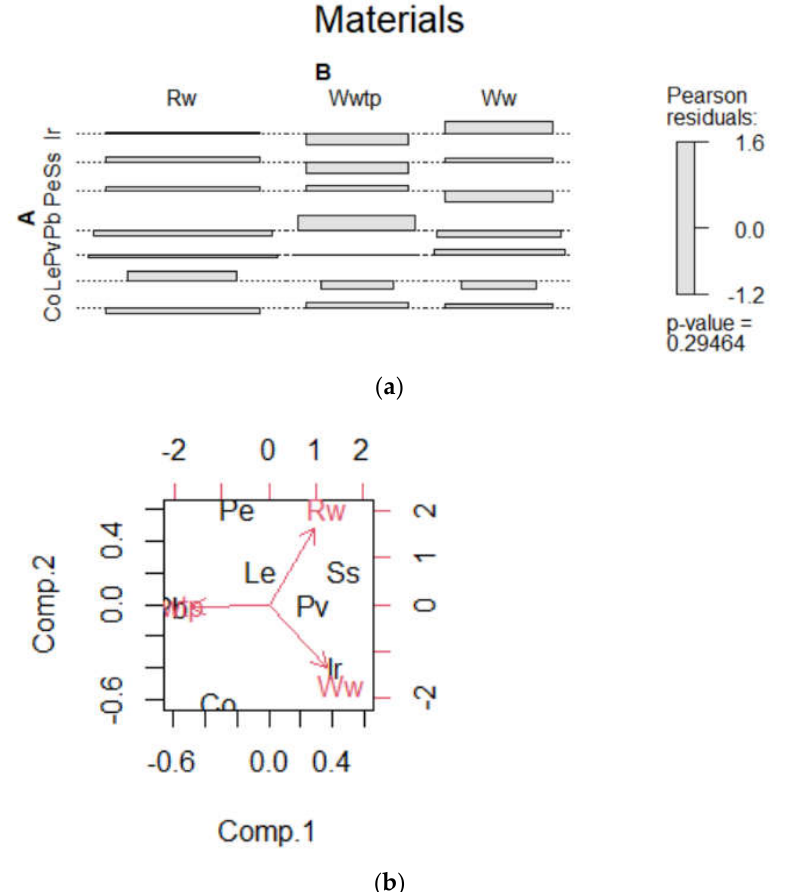
Figure 1. ( a ) Material–type of water, Pearson’s residuals; ( b ) Material–type of water, biplot. Recycled water (Rw), wastewater treatment plant water (Wwtp), well water (Ww). Copper (Co), lead (Le), iron (Ir), stainless steel (Ss), polybutylene (Pb), polyethylene (Pe), polyvinyl chloride